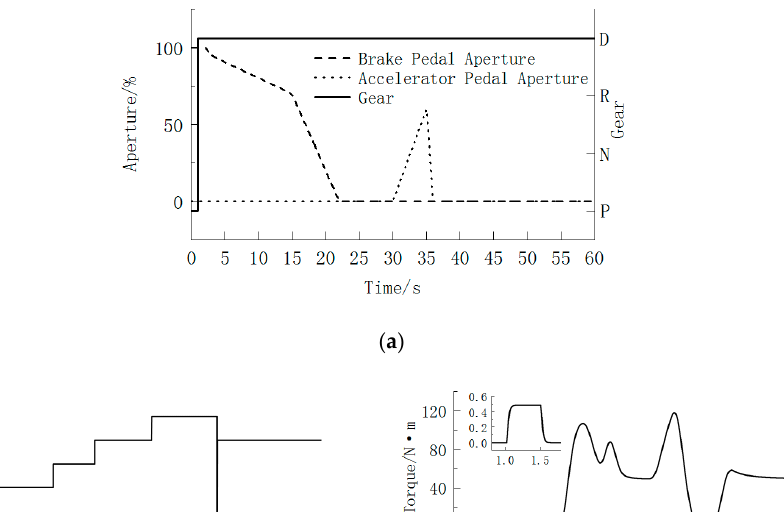
( c ) Figure 14. Control Process of 32% Inclination Condition: ( a ) Curve of Motor Output Torque; ( b ) Curve of Vehicle Velocity; ( c ) Curve of Jerk.